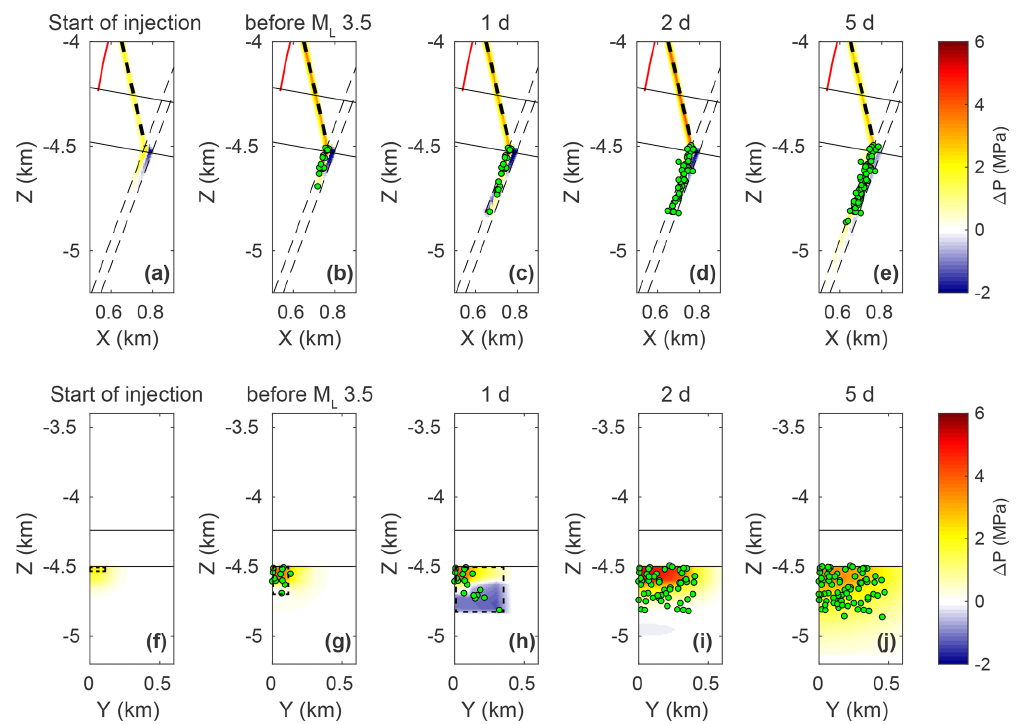
Figure 10. (a–e) Pressure change and simulated seismicity (single realization) during the gas kick and well control measures at y = 0km after (a) ca. 0.4d (start of injection), (b) 0.99d (shortly before the M L 3.5 event), (c) 1d (immediately after the M L 3.5 event), (d) 2d, and (e) 5d of simulation time along profile A–A (cid:48) in Fig. 2 (normal to the fault). The open section of the well is denoted by the red line. The fault is illustrated by the thin dashed black lines, the fracture zone by the thick dashed black line, and the caprock by the solid black lines. (f–j) Pressure change and simulated seismicity (single realization) on the fault (left damage zone) after (f) approx. 0.4d (start of injection), (g) 0.99d (shortly before the M L 3.5 event), (h) 1d (immediately after the M L 3.5 event), (i) 2d, and (j) 5d of simulation time along profile B (cid:48) –B in Fig. 2 (along fault). The solid black lines indicate the caprock. The dashed black rectangles denote the area of permeability change to (f) initiate the gas kick, due to (g) the M L 2.1 event, and because of (h) the M L 3.5 event.